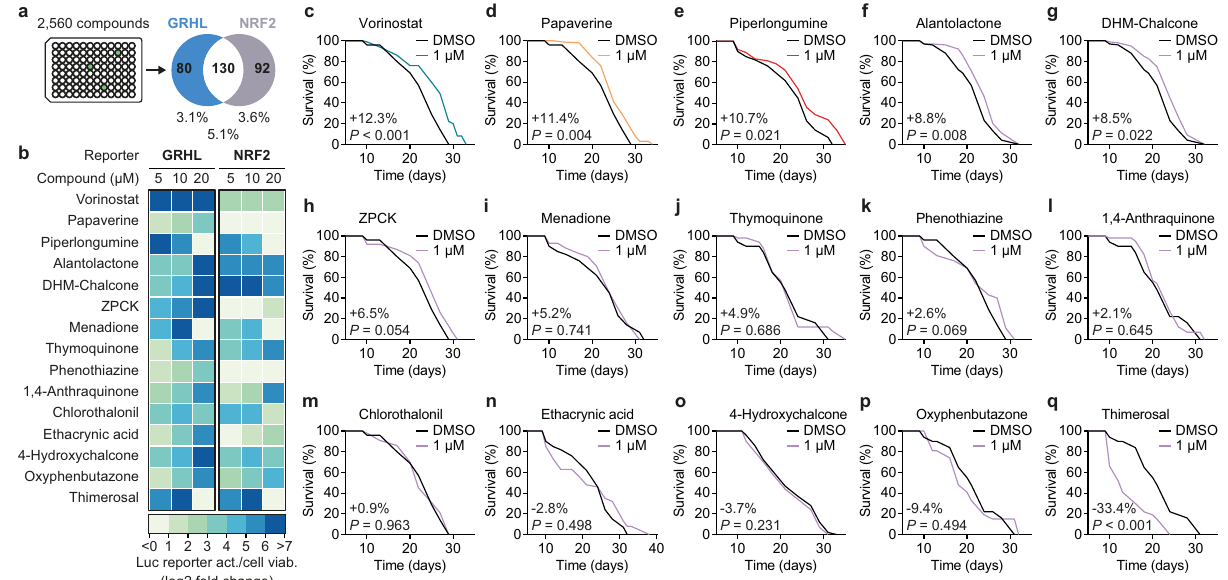
Fig. 2 Human GRHL1-activating compounds and their impact on nematodal lifespan. a Schematic Venn diagram of hits activating a human GRHL and/or NRF2 luciferase reporter with fold change ≥ 2 at 10 µ M in the primary screening. Indicated are total number of hits and hits as percentage of full library (2560 compounds). See Supplementary Data 4. b Heat map depicting log2 fold change reporter activation in a three-point dose – response assay (5, 10, and 20 µ M) of the top 15 GRHL hit compounds on the reporters as in ( a ), normalized to cell viability ( n = 2 – 3 per condition). c – q Lifespan assays, all using WT (N2) nematodes treated with the respective individual compound at a concentration of 1 µ M in plate and vs. DMSO control. Lifespan graphs contain percentage change of mean lifespan compound vs. DMSO control and P -values as determined by log-rank test. See Supplementary Data 1 for detailed lifespan assay statistics. Source data are provided as a Source data fi (63.7 ± 2.9 fold, P = 8.7 × 10 − 13 ; Supplementary Fig. 3c), selected